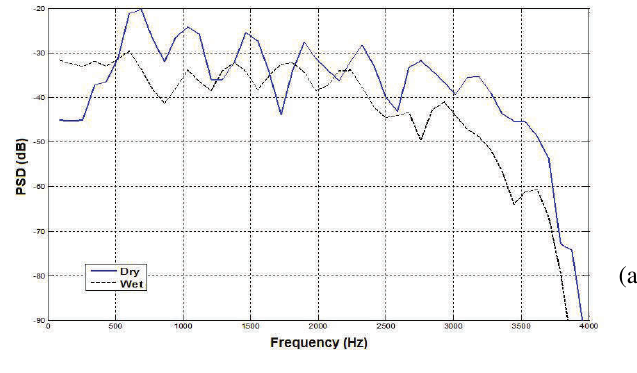
Figure 5. Power spectrum densities of free-decay response signal of dry and wet plate.